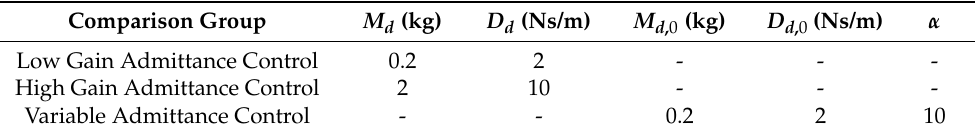
Table 4. Parameters of comparative controllers for experiments.